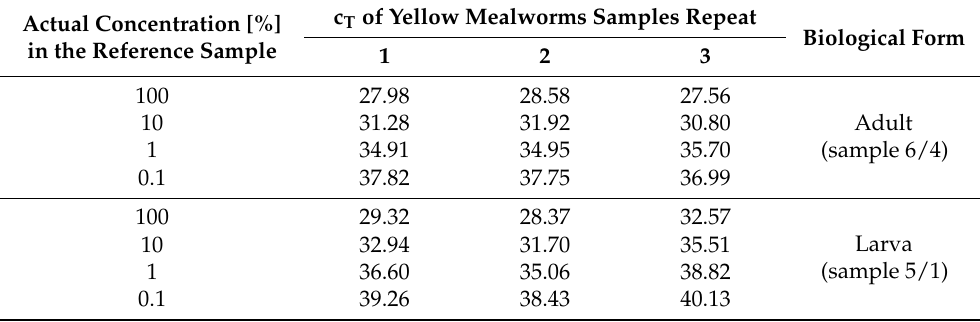
Table 6. Inter-laboratory validation results of the real-time PCR system using standard curves for three different samples—reaction results.